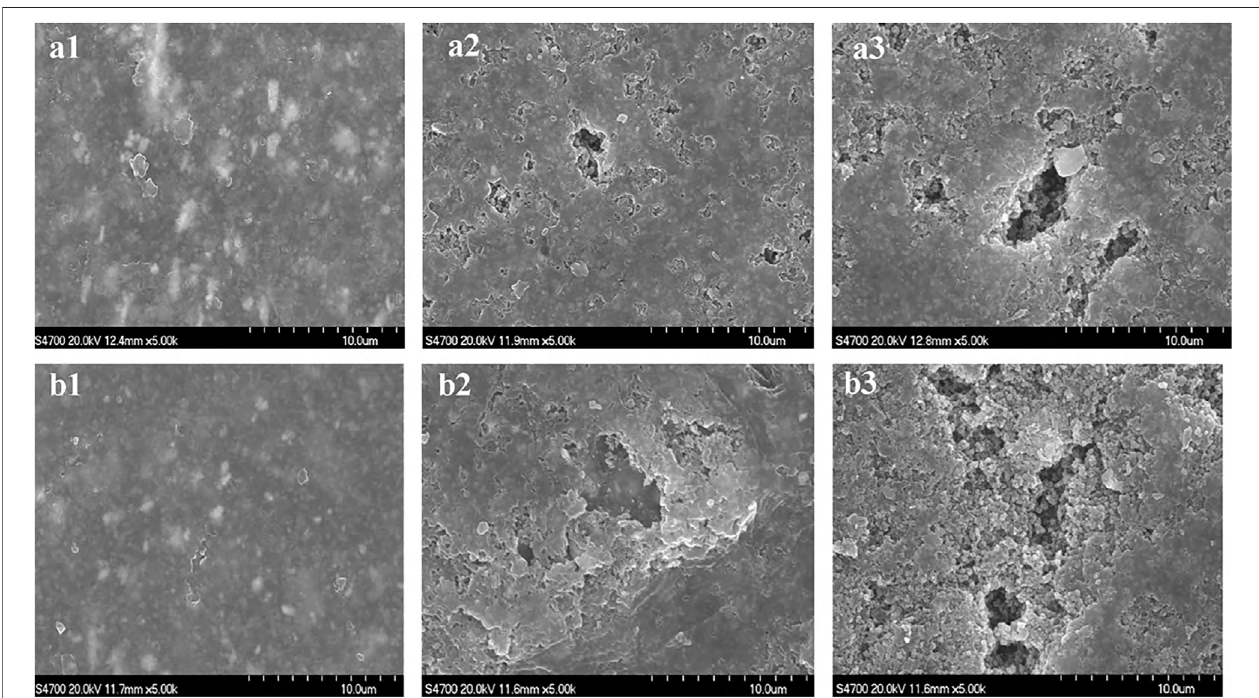
FIGURE 11 | Surface morphology of the polyurethane composite coatings immersed in 3.5% NaCl solution for 3 h, 2.25 and 35 days, respectively: (A) acrylic polyurethane composite coating and (B) aliphatic urethane composite coating.